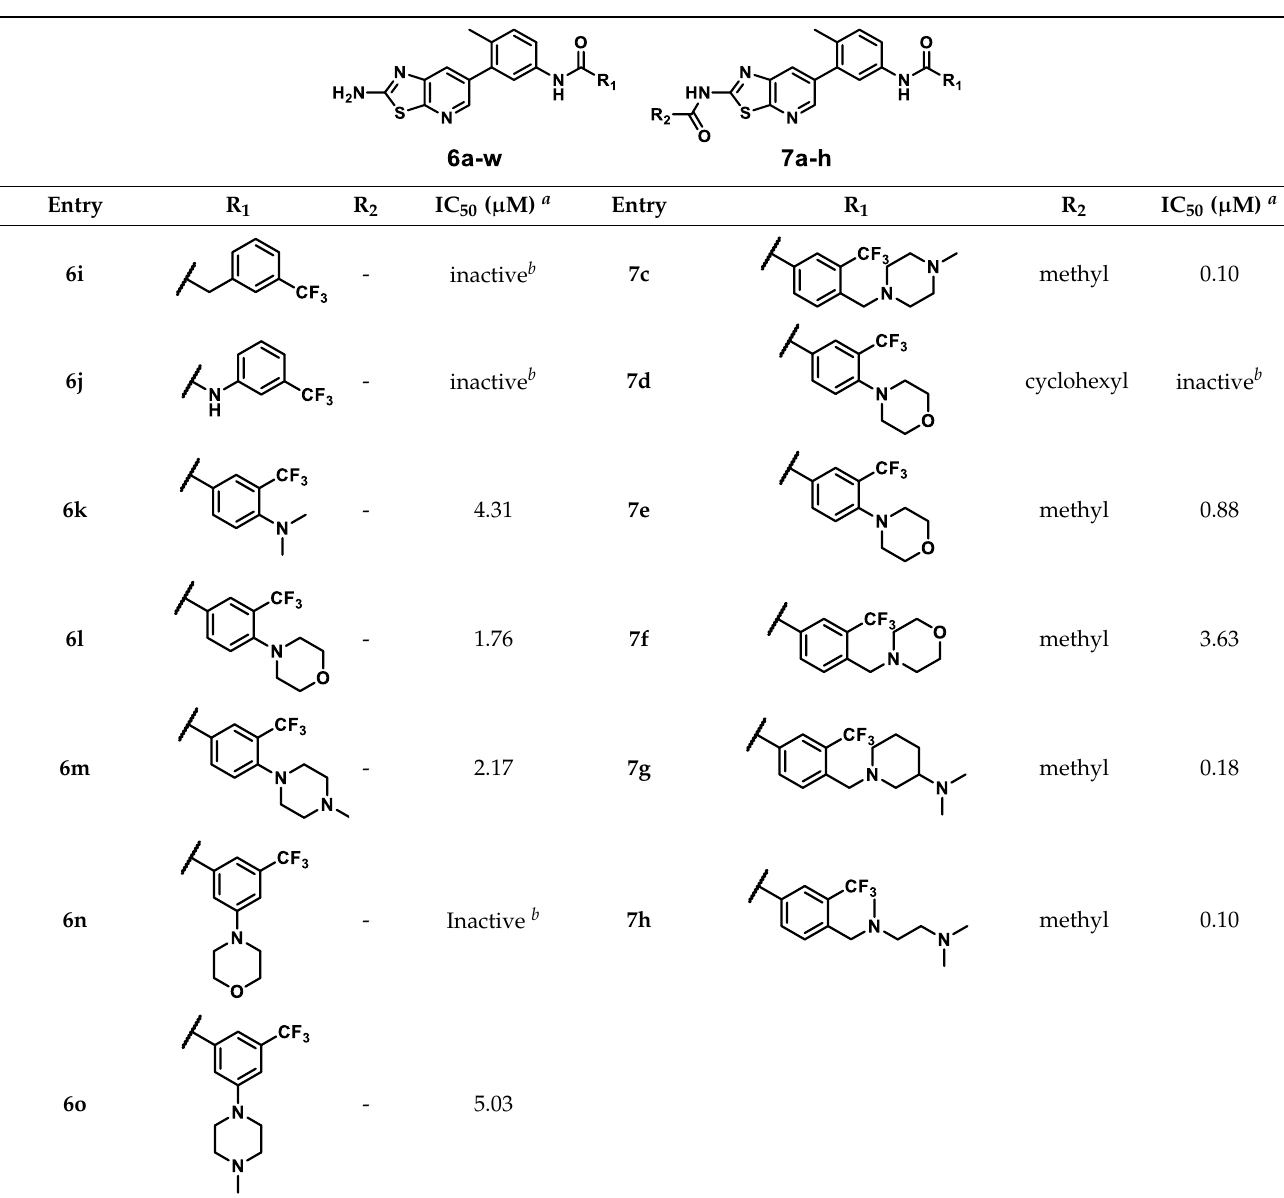
Table 1. Enzymatic inhibitory activities of thiazolo[5,4- b ]pyridine derivatives 6a – w and 7a – h Table 1. Cont. against c-KIT.